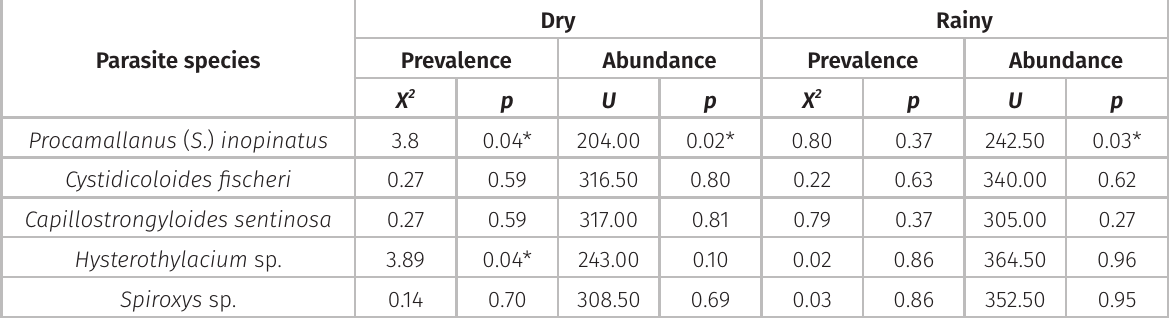
Table IX. Analysis of parasite indexes under the possible influence of the collection period (dry and rainy seasons) of Pygocentrus piraya from Três Marias reservoir, upper São Francisco river, state of Minas Gerais, Brazil. Prevalence Intensity Abundance Parasite species Χ 2 p U p U p Procamallanus ( S .) inopinatus 0.006 0.93 715.00 1099.00 0.03* Cystidicoloides fischeri 0.32 Capillostrongyloides sentinosa 19.29 <0.0001* - - 852.50 0.0002* Hysterothylacium sp. 21.54 <0.0001* 146.00 0.59 839.00 0.0001* Spiroxys sp. 0.62 0.37 *significant values; p <0.05; Χ 2 : Chi-square test with Yates’s correction; U : Mann Whitney test. - Impossible to calculate because all the fish collected in dry period presented only one specimen. Table X. Parasitic descriptors during collect periods (dry and rainy seasons, respectively) under possible influence of sex of Pygocentrus piraya from Três Marias reservoir, upper São Francisco river, state of Minas Gerais, Brazil. Dry Rainy Parasite species Prevalence Abundance Prevalence Abundance Χ 2 p U p Χ 2 p U p Procamallanus ( S .) inopinatus 3.8 0.04* Cystidicoloides fischeri Capillostrongyloides